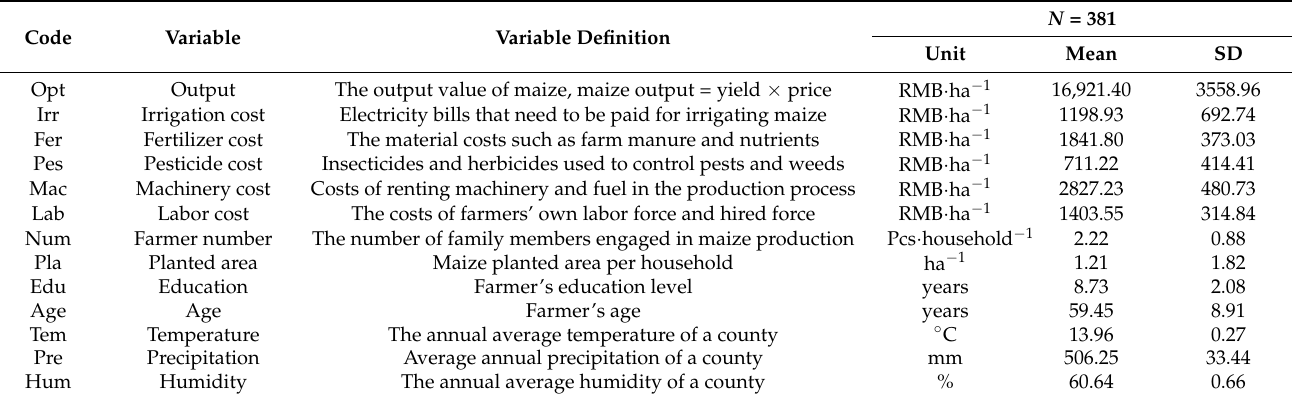
Table 1. Variable settings and descriptive Statistics.